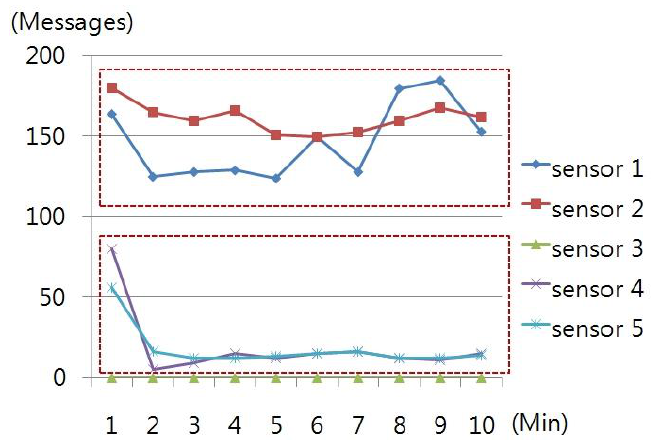
Figure 3. Normal message